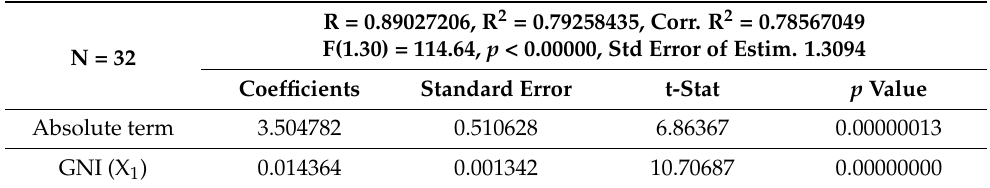
Table 3. Results of modeling the share of renewable energy sources in gross marginal energy consumption in Poland in 1991–2022 using a linear econometric model of one variable.